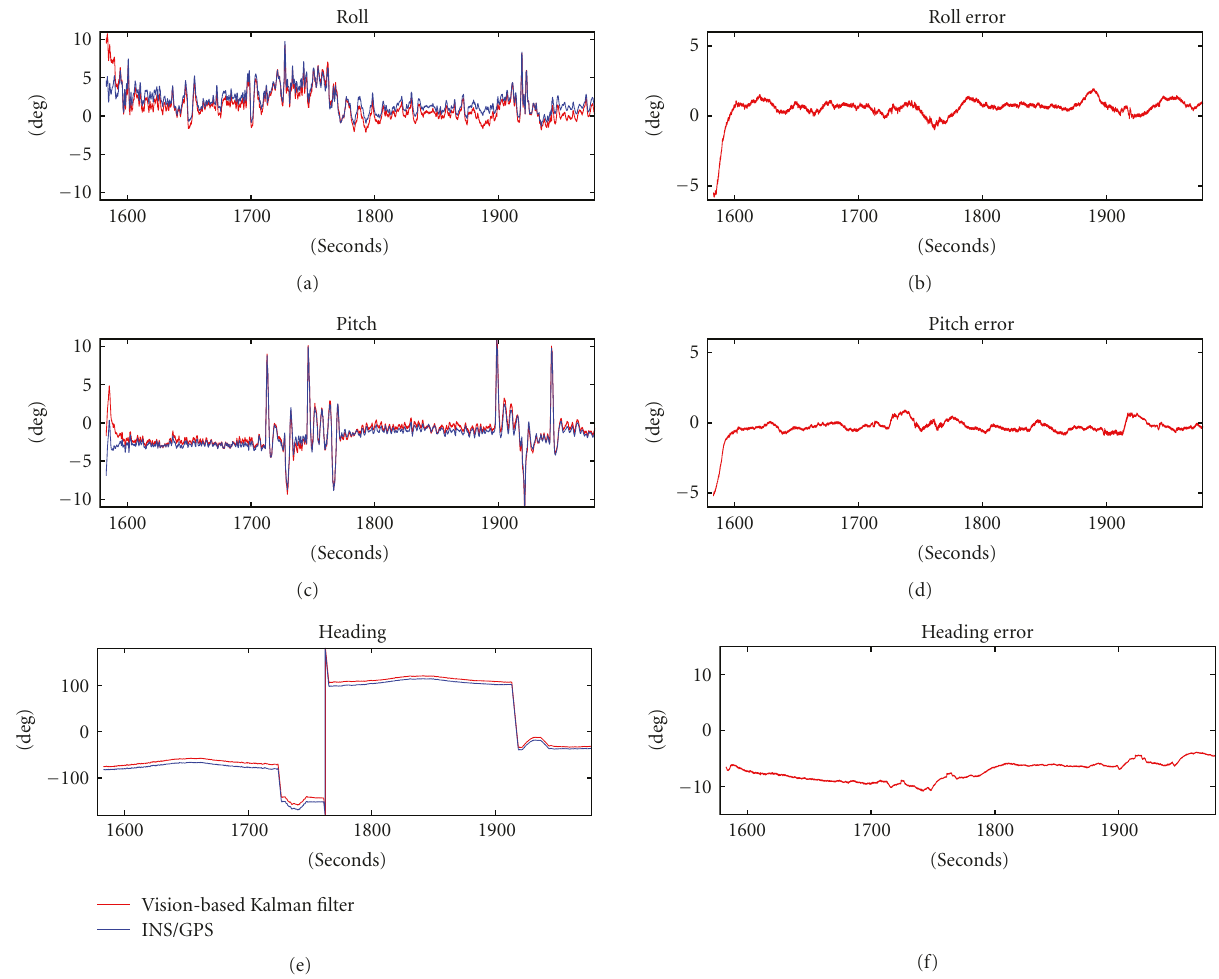
Figure 14: Estimated Kalman filter attitude angles with an initial 5-degree error added for roll, pitch, and heading angles. It can be observed how the pitch and roll angles converge quite rapidly, while the heading shows a weak converge tendency.